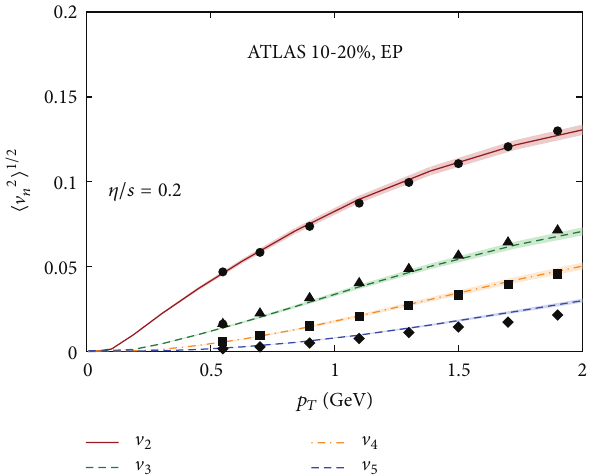
Figure 19: ATLAS measurements for the flow coefficients V 𝑛 , 𝑛 = 2 , 3, 4, 5 are compared with IP-Glasma model predictions. The figures are from